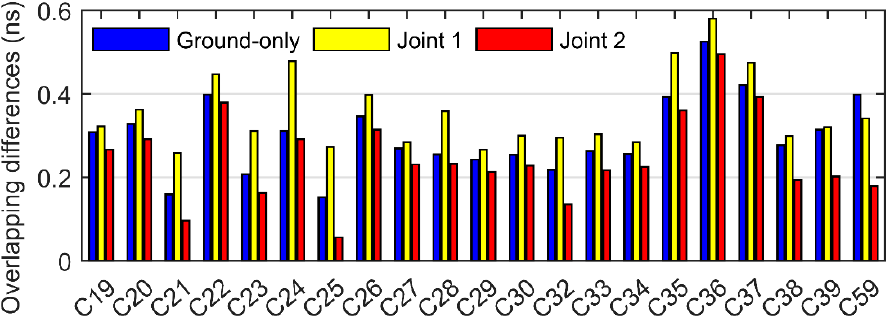
Figure 4. Two-day overlapping differences of clock offsets estimated by ground-only POD, Joint 1 POD, and Joint 2 POD.